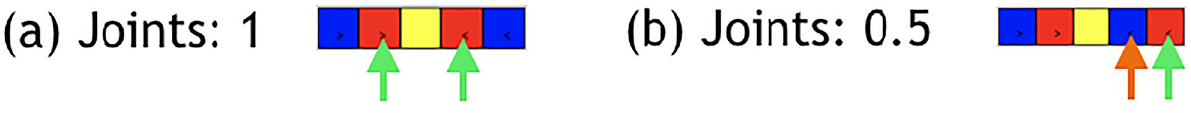
Fig 9. Although both morphologies have two joints, in (b) the second joint is not effective, and would be only if the module indicated by the green arrow was switched with the one indicated by the orange